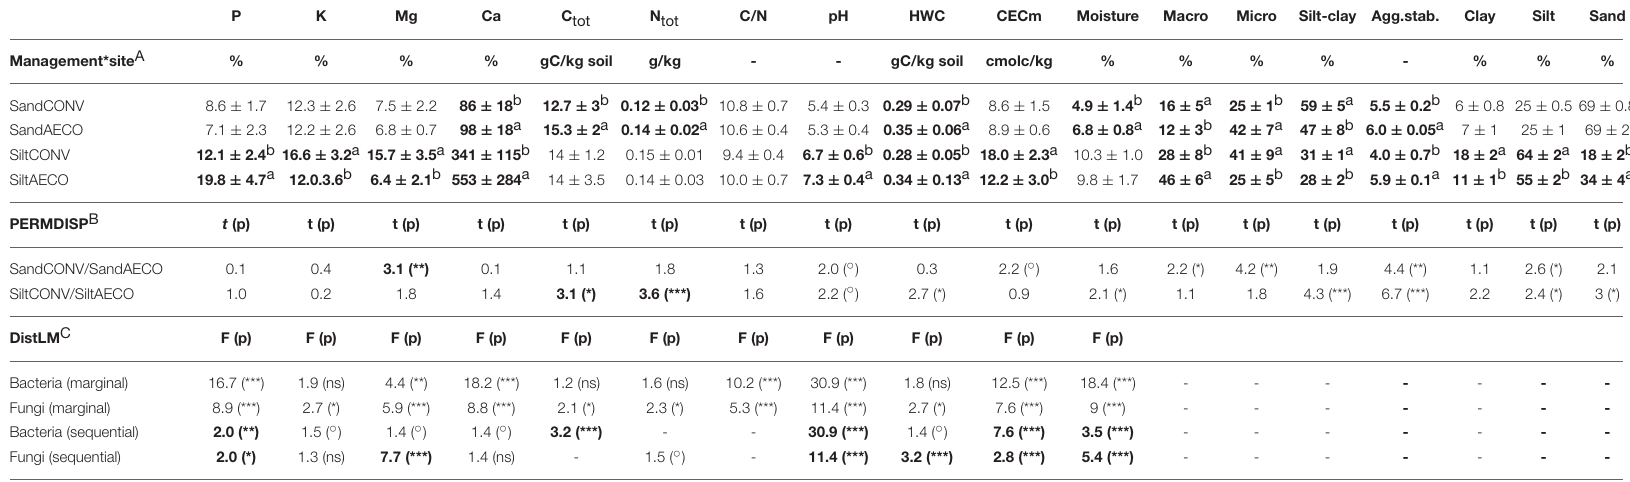
(A) Mean and standard deviation of the soil physical and chemical parameters for each management type (CONV, conventional and AECO, agroecological) at the two textural sites (sandy and silty). The management effect was assessed at the two textural sites separately using a pairwise test with the routine PERMANOVA implemented in Primer6. Letters “a” and “b” represent the highest and the lowest values between the two management types. (B) Test for the homogeneity of variance as assessed with the routine PERMDISP implemented in Primer6. Values are the t-statistics (t) and p-value (p). (C) Distance based linear model to assess the relationship between β -diversity and soil parameters using the DistLM routine from Primer6. Marginal means that each factor was added in the model ignoring the other factors, sequential means that each factor is fitted after taking into account all previous factors in the model. Values are the F-ratio (F) and p-value (p). Significance level: p < 0.001 *** ; p < 0.01 ** ; p < 0.05 * , and p < 0.1 ◦ . The significant tests (p < 0.05) are in bold. P, K, Mg, and Ca, exchangeable cations; agg.stab, aggregate stability; C tot , carbon total; clay, % of clay particles; silt, % of silt particles; sand, % of sand particles; micro, % of micro-aggregates; macro, % of macro-aggregates; silt.clay, % of silt and clay fraction; C/N, carbon to nitrogen ratio; HWC, hot water carbon; N tot , total nitrogen; CEC, cation exchange capacity. The seven last parameters in the table were not included in the DistLM analysis because these parameters did not have the same number of replicates as the other